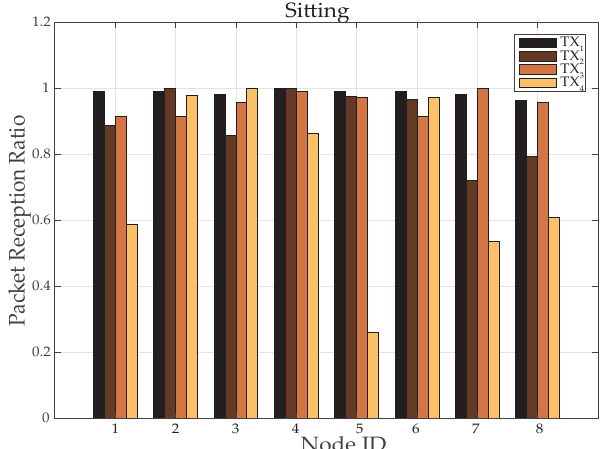
Figure 20. Packet Reception Ratio at various nodes while sitting activity.